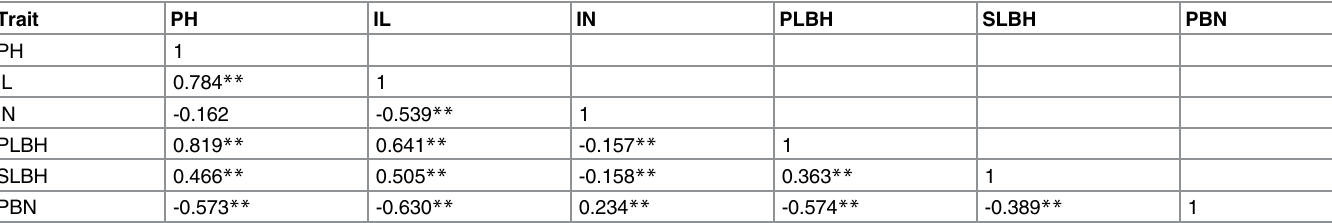
-0.630 ** 0.234 ** -0.574 ** -0.389 ** 1 ** indicates a signi fi cant correlation at P < 0.01.